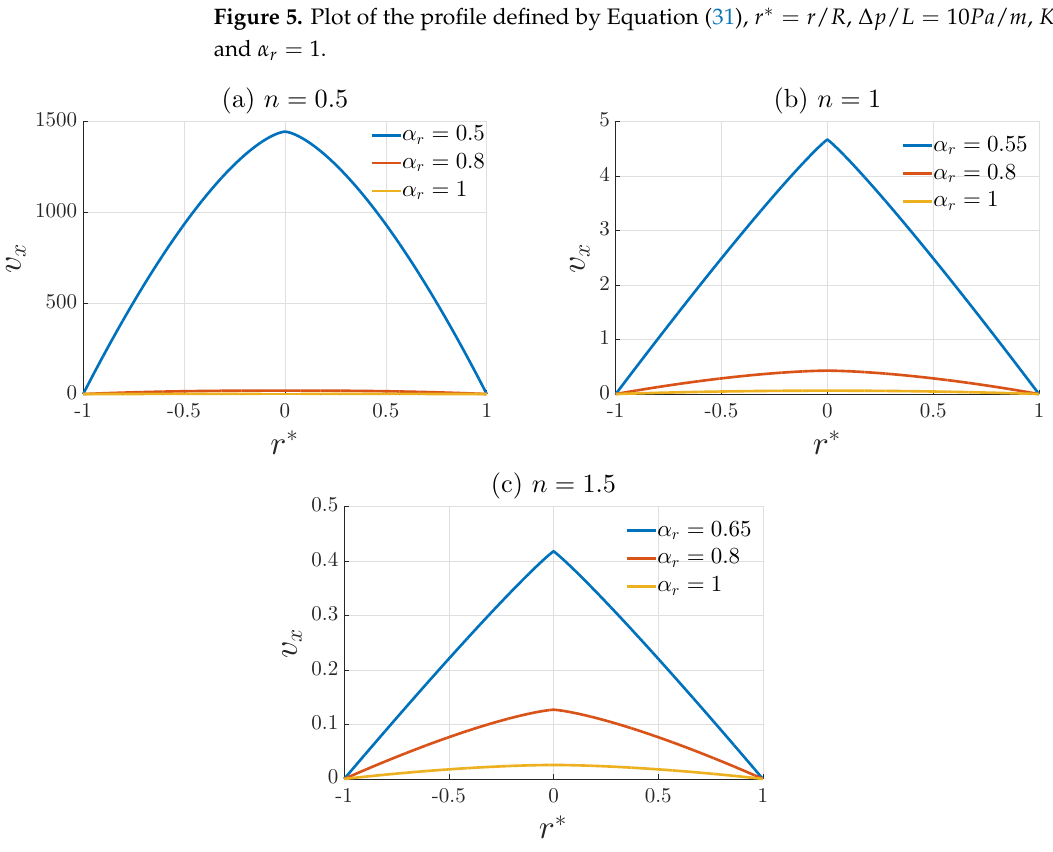
Figure 6. Plot of the profile defined by Equation (31), r ∗ = r / R , ∆ p / L = 10 Pa / m , K 0 = 10 − 3 Pa . s n , d x = 1 and the values permitted for α r in ( a ) 0.34 < α r ≤ 1, ( b ) 0.5 < α r ≤ 1 and ( c ) 0.6 < α r ≤